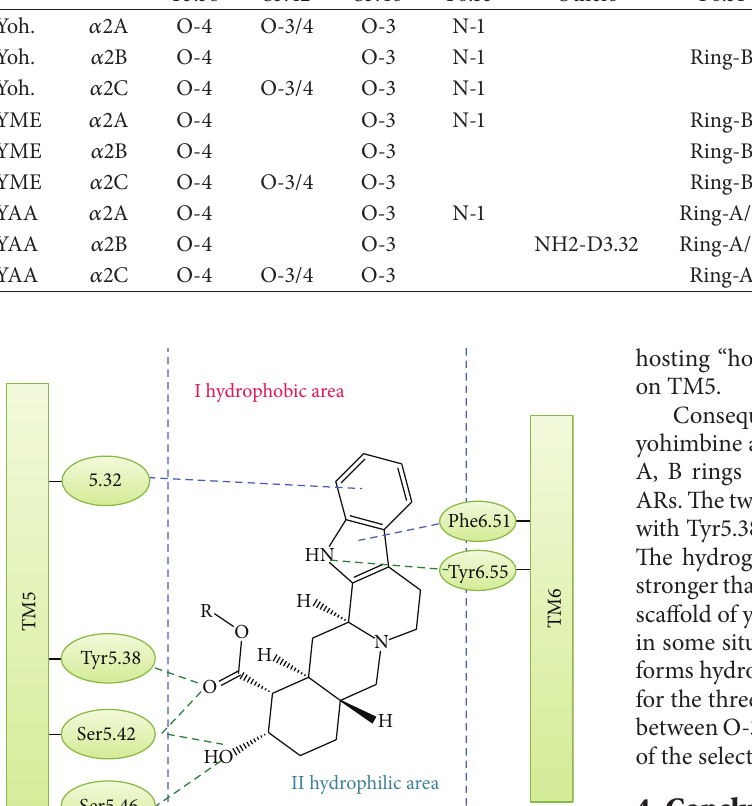
Table 2: Summary on the interactions between 3 ligands and the 3 𝛼 2 subtypes. ligands